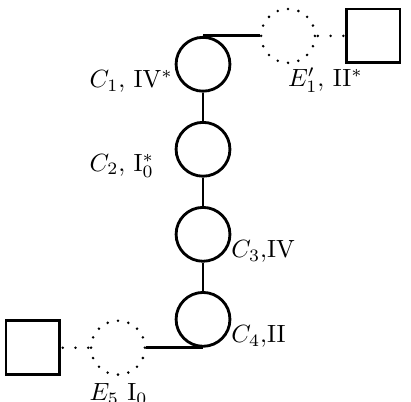
Figure 14. Partial resolution of local singularity with k = 5, of a form y 2 = x 3 + ( z 0 ) 5 z 5 . Although the supported singularities are di(cid:11)erent, the base geometry is identical to the previous A 4 case. Compare with (cid:12)gure